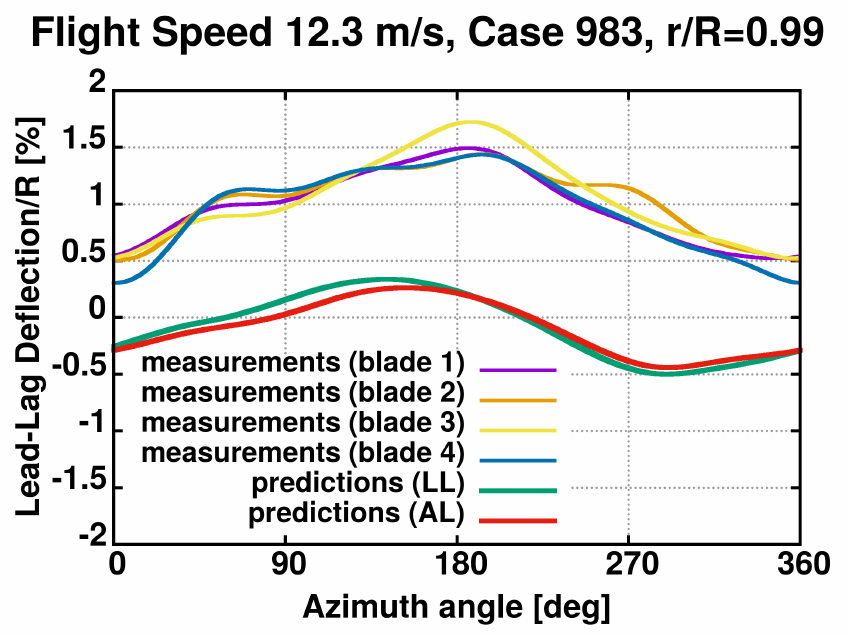
Figure 37. Forward flight at 12.3 m/s, case 983. Lead-lag deflection at r / R =